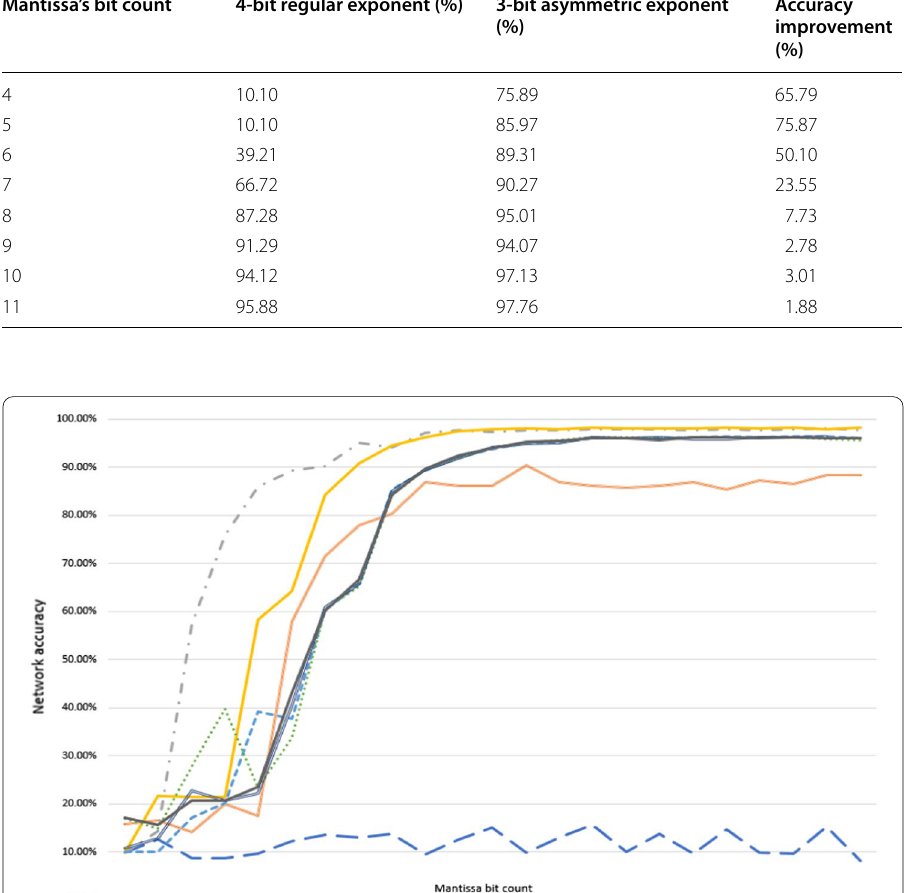
Table 4 Neural network accuracy comparison between 4-bit exponent and 3-bit asymmetric exponent Mantissa’s bit count